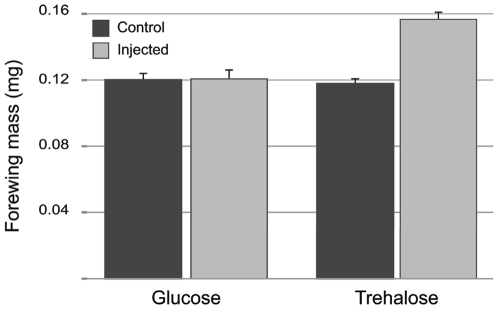
Effect of glucose and trehalose injection on wing disk growth.Glucose and trehalose were injected 3 times at 12h interval during 48 h. Each bar represents the mean of 6–10 disks. Error bars SEM.